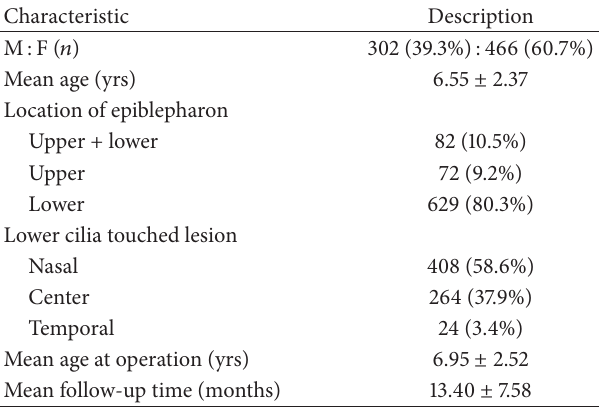
Table 1: Patient demographic characteristics.